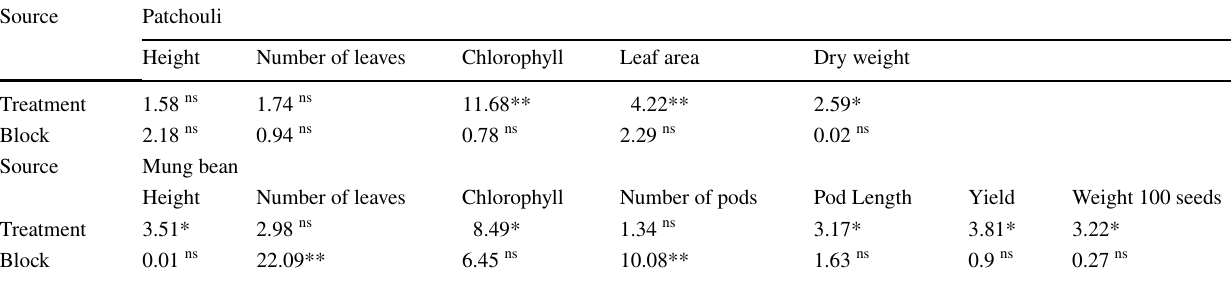
Table 4 Significance of the effects of treatments and block on growth parameters of patchouli and mung bean using ANOVA